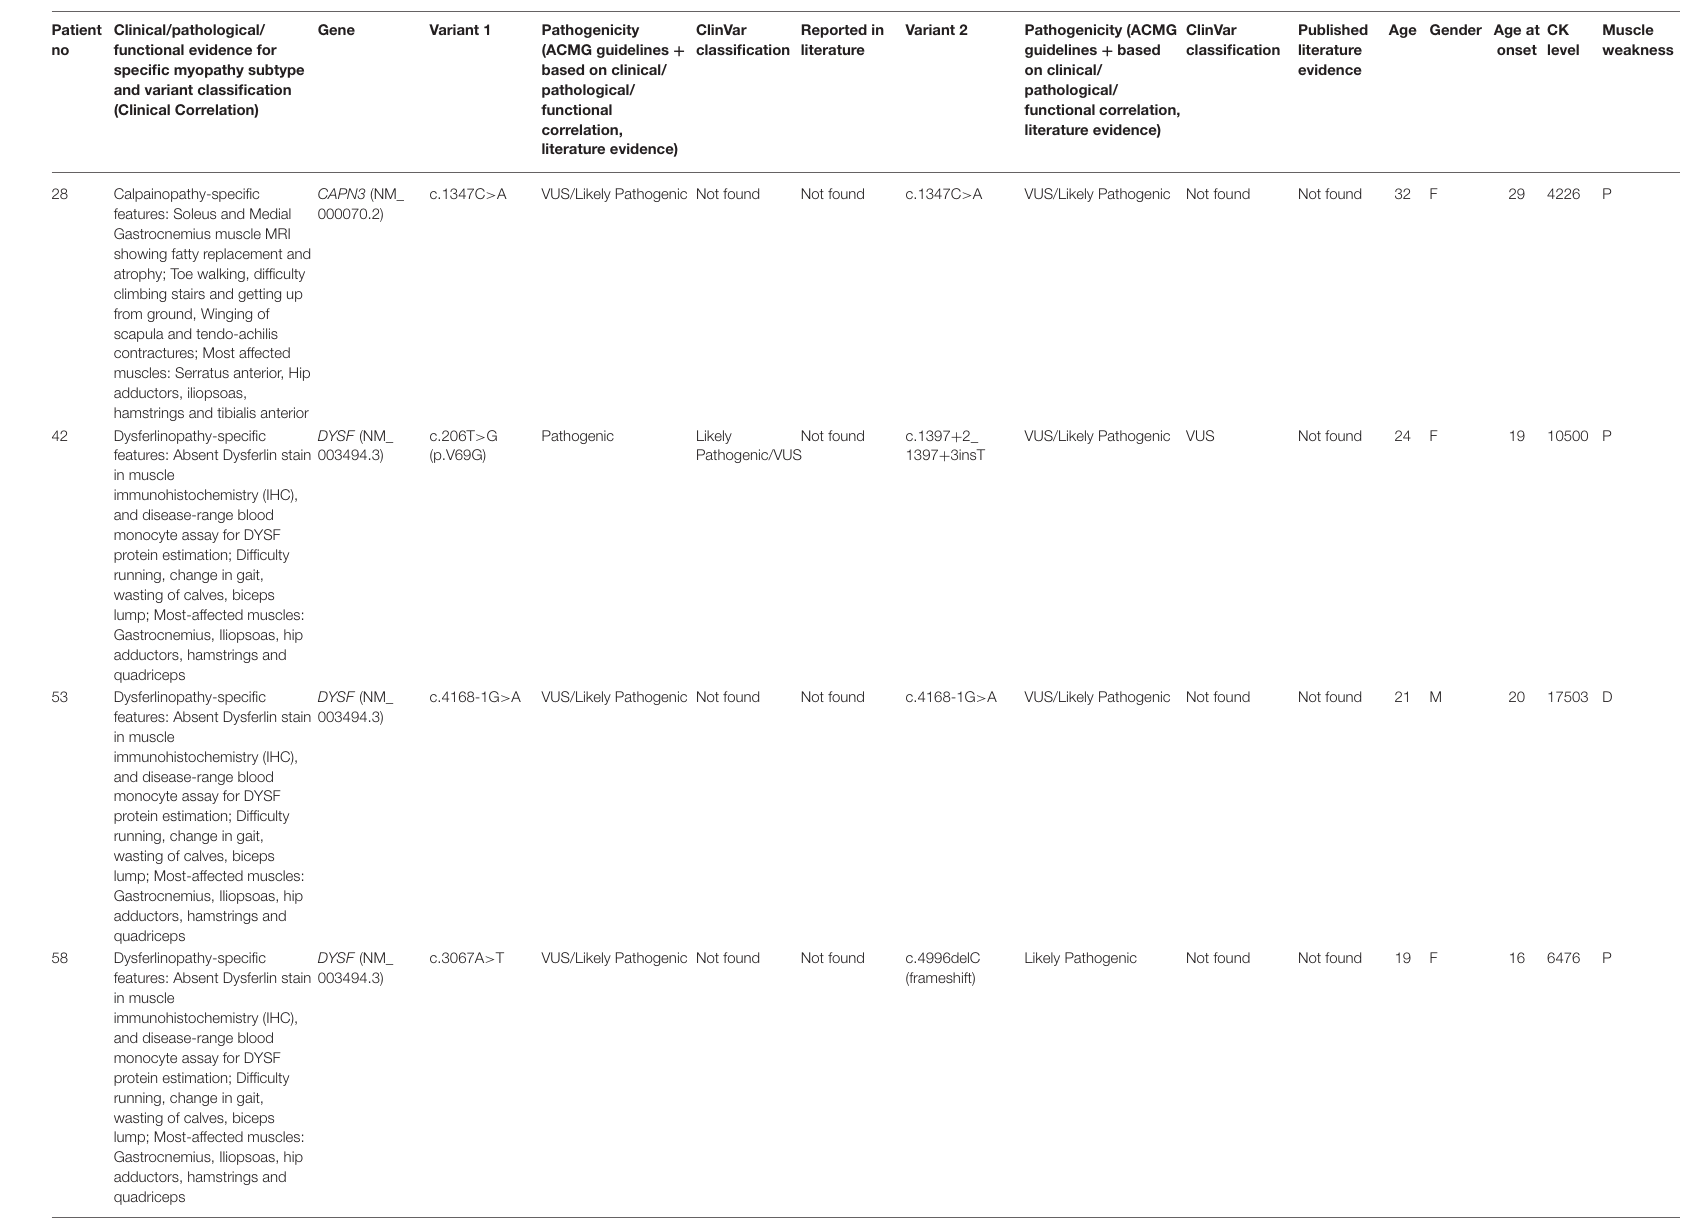
Dysferlinopathy-specific features: Absent Dysferlin stain in muscle immunohistochemistry (IHC), and disease-range blood monocyte assay for DYSF protein estimation;